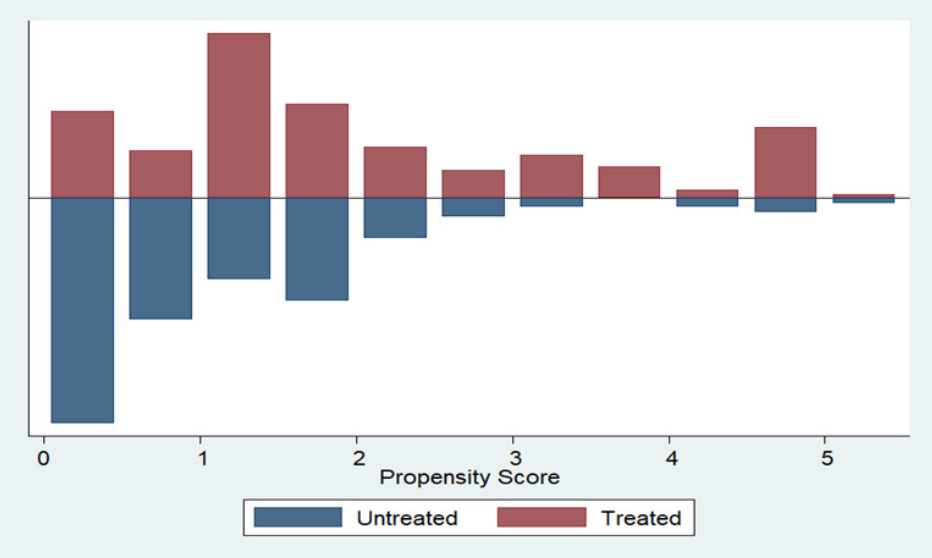
Figure 8. Propensity score distribution.